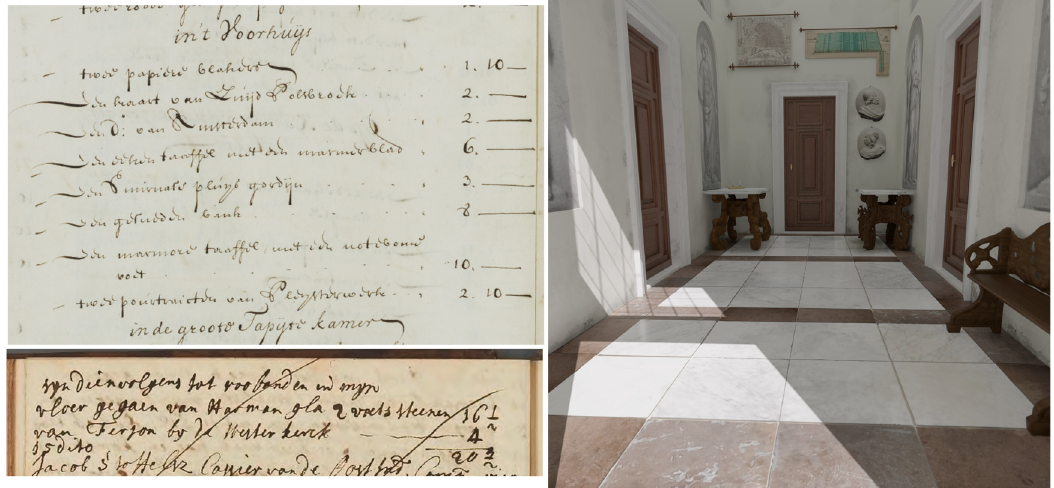
Figure 2: The section of De Grae ff ’ s probate inventory concerning the items recorded in the voorhuis ( top left ) ; one of the passages of his almanacs where he noted down the number of red tiles that were used as bands in his voorhuis ( bottom left ) . On the right: the proposed reconstruction hypothesis of De Grae ff ’ s voorhuis discussed in Piccoli ( 2021 )